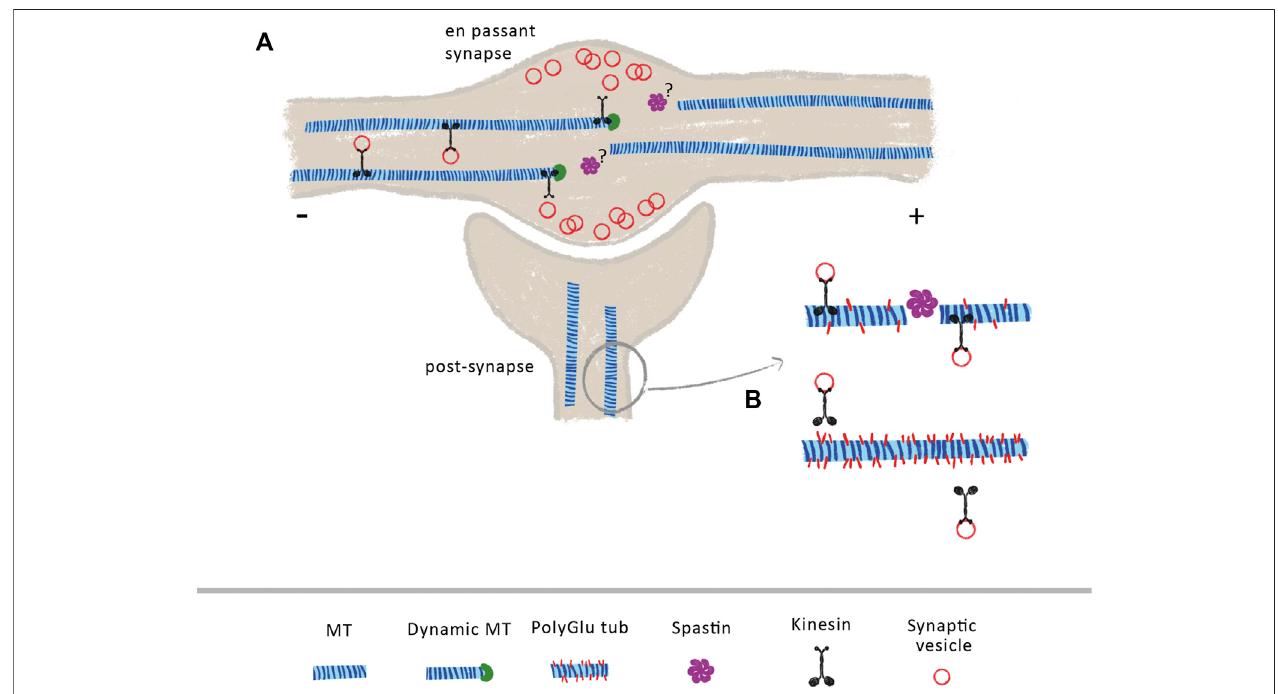
FIGURE 1 | Spastin at pre- and post-synaptic sites (A) At axonal en passant synapses, the axonal transport of synaptic vesicles is dependent on the increase dynamics of MTs. Due to the weak af fi nity of kinesin-3 to MT GTP-bound tubulin, these molecular motors detach from MTs when they encounter their dynamic plus- ends,releasingtransportedcargoeswithinthesynapse.ThemechanismsunderlyingincreaseMTdynamicsatthesesitesarecurrentlyunderinvestigation.Duetoitsrole in MT dynamics, the control of spastin activity at axon pre-synapses might contribute to generate a pool of dynamic MTs (B) At post-synapses, spastin indirectly modulates the transport of synaptic vesicles and AMPA receptors through the control of tubulin polyglutamylation levels. Loss of spastin increases tubulin polyglutamylation levels, decreasing the binding af fi nity of KIF5, leading to transport